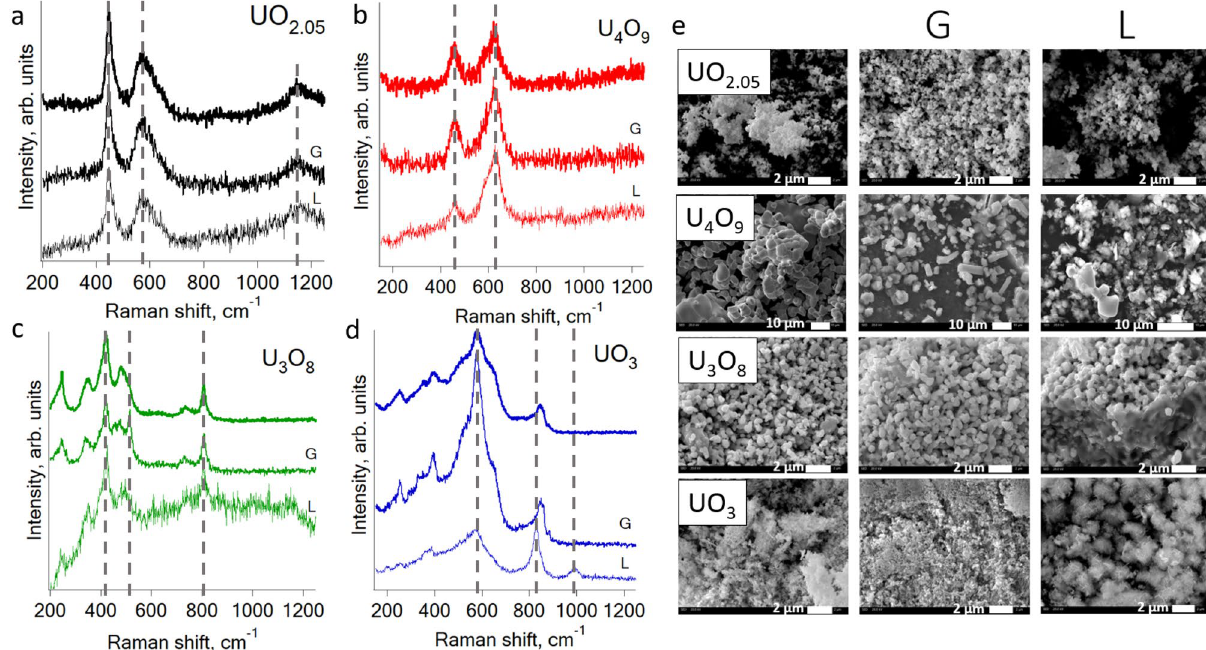
Figure 2. Raman spectra of uranium oxides before and after exposure in simulated lungs (L) and gastro- intestinal (G) liquids: ( a ) UO 2.05 ; ( b ) U 4 O 9 ; ( c ) U 3 O 8 ; ( d ) UO 3 . ( e ) SEM images of UO 2.05 before and after